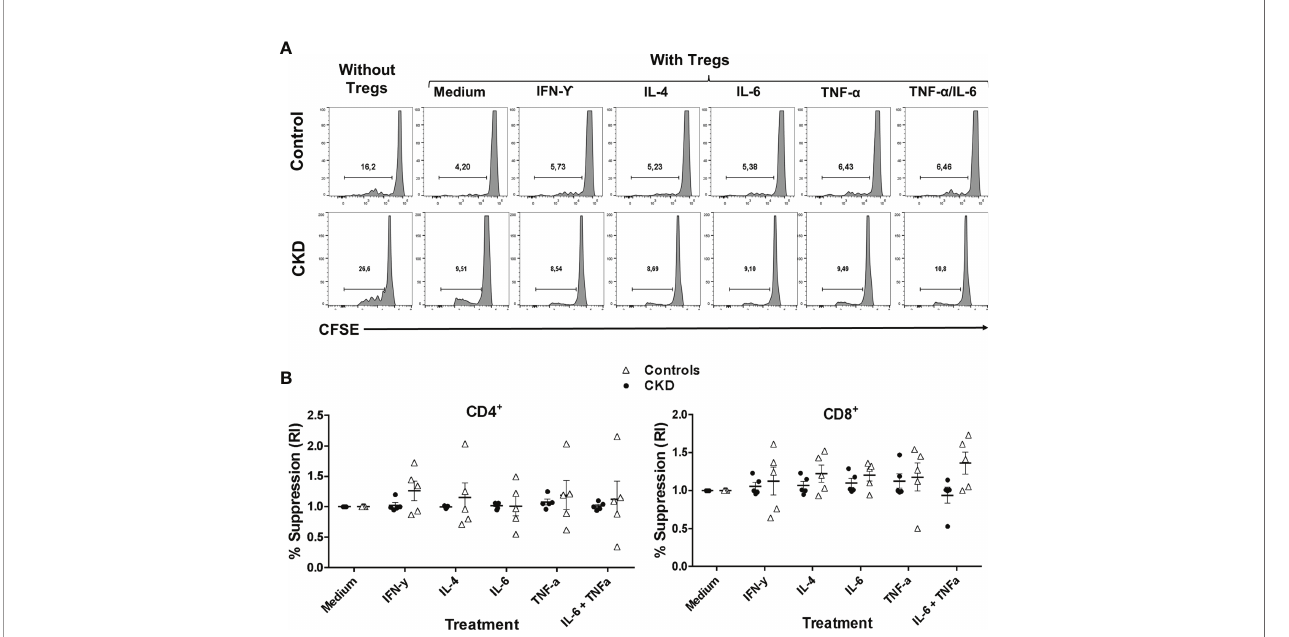
FIGURE 7 | Allospeci fi c regulatory T cells ( allo Tregs) maintained their in vitro function after stimulation in an in fl ammatory microenvironment. Long-term expanded allo Tregs from healthy individuals ( white triangles , n = 5) or patients with chronic kidney disease (CKD) ( black circles , n = 5) were stimulated with anti-CD3/anti-CD28 in the presence or absence of in fl ammatory cytokines for two additional weeks, and then in vitro allospeci fi c suppression assays were performed. (A, B) The allo Tregs from both patients and healthy controls maintained their capacity to suppress both CD4 + ( left ) and CD8 + ( right ) T-cell proliferation after expansion in the presence of all the in fl ammatory cytokines evaluated (IFN- g , IL-6, IL-4, and TNF- a ). A representative experiment is shown in (A) . The relative increase (IR) of the percentage of suppression was calculated by dividing the value in the presence of the cytokine by the value in the absence of cytokines (medium). All experiments were performed in duplicate. The results are shown as the mean ± SEM. Statistical analysis was performed using the Kruskal – Wallis test. No signi fi cant differences were